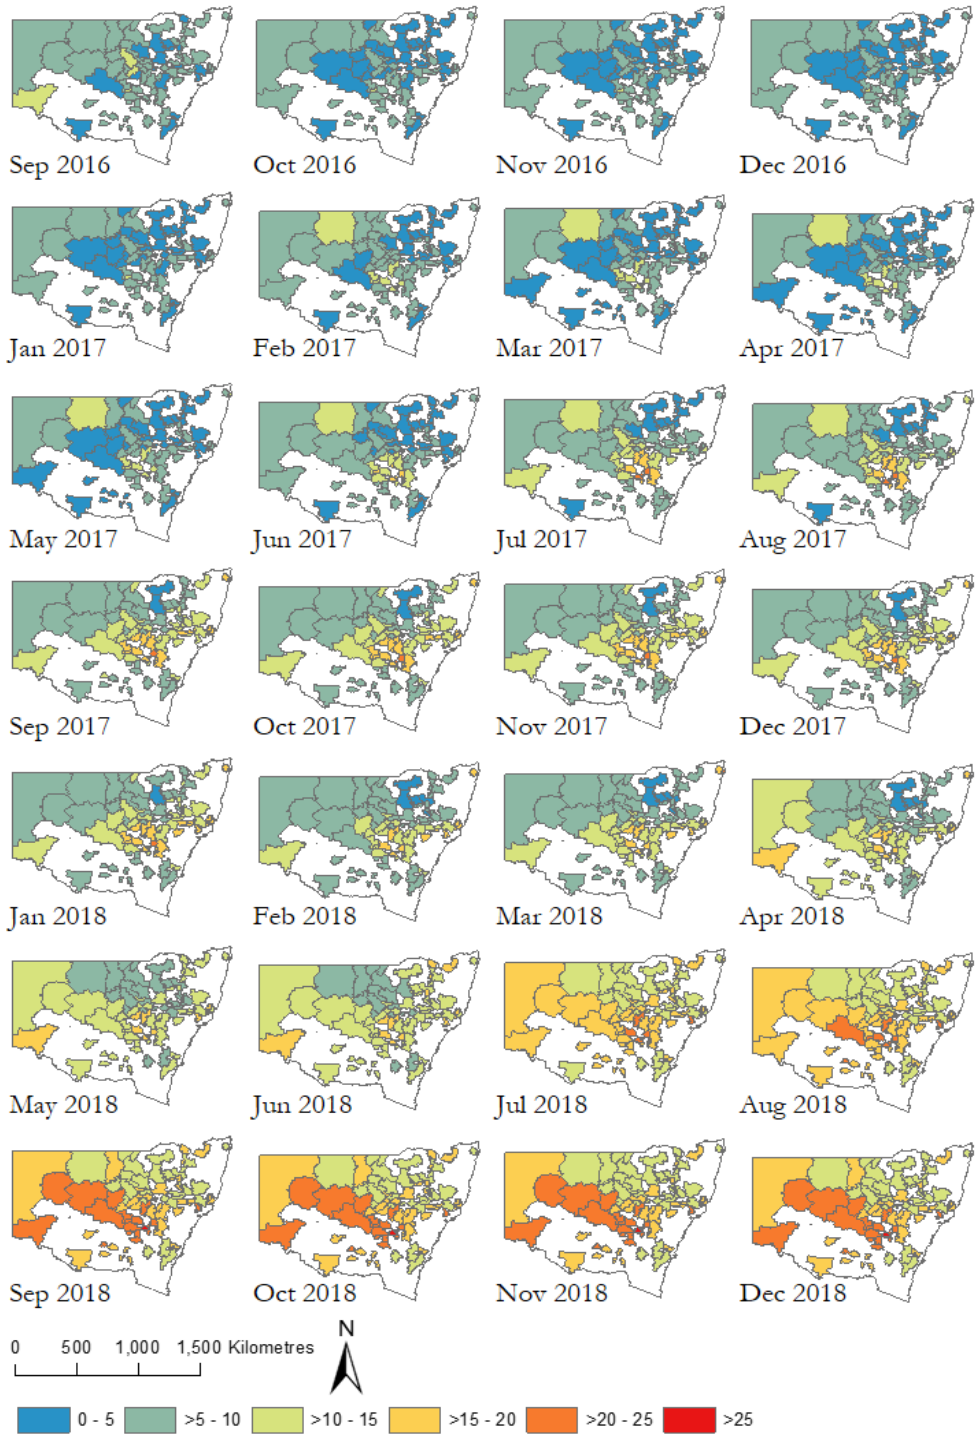
Figure 6. Percentage of months below precipitation decile 1 (24-month time window) for the postcodes where participants resided.